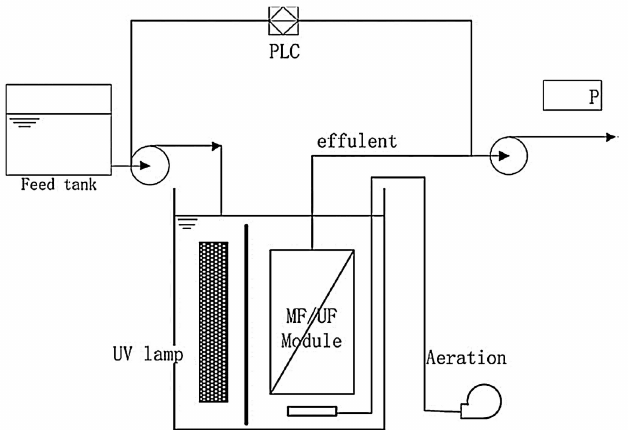
Figure 5. Schematization of the experimental SPMR used by Zheng et al. Reprinted with permission from ref. [48]. Copyright © 2021 Elsevier B.V.